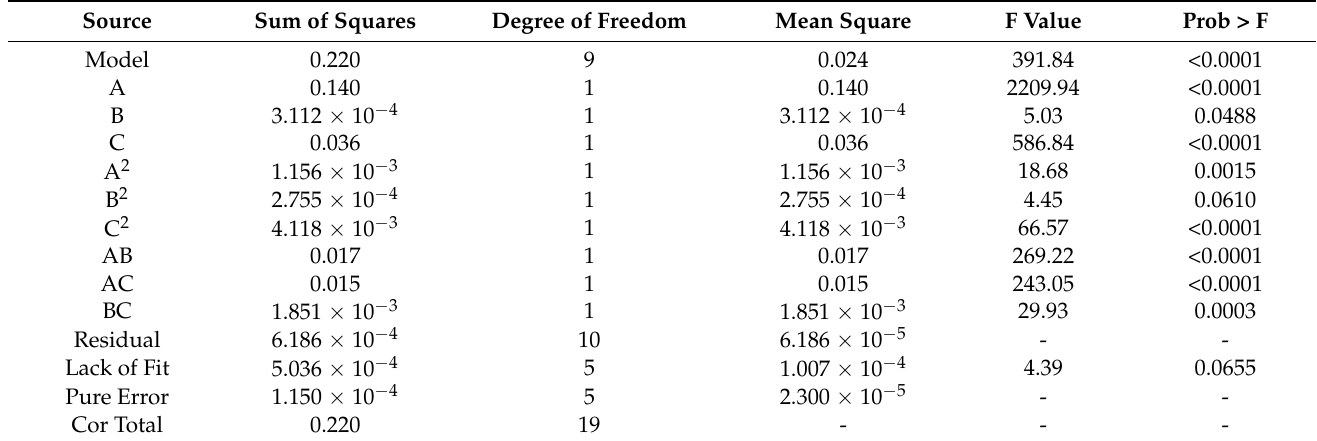
Table 4. ANOVA of CO 2 /H 2 separation selectivity.